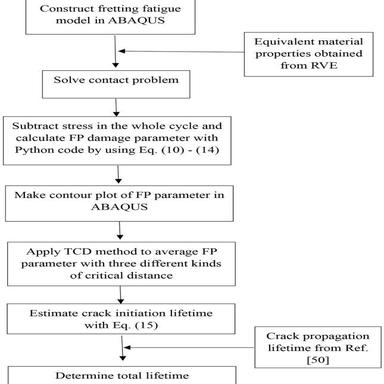
A flowchart for the calculation of FP parameter and estimation of fretting fatigue lifetime.